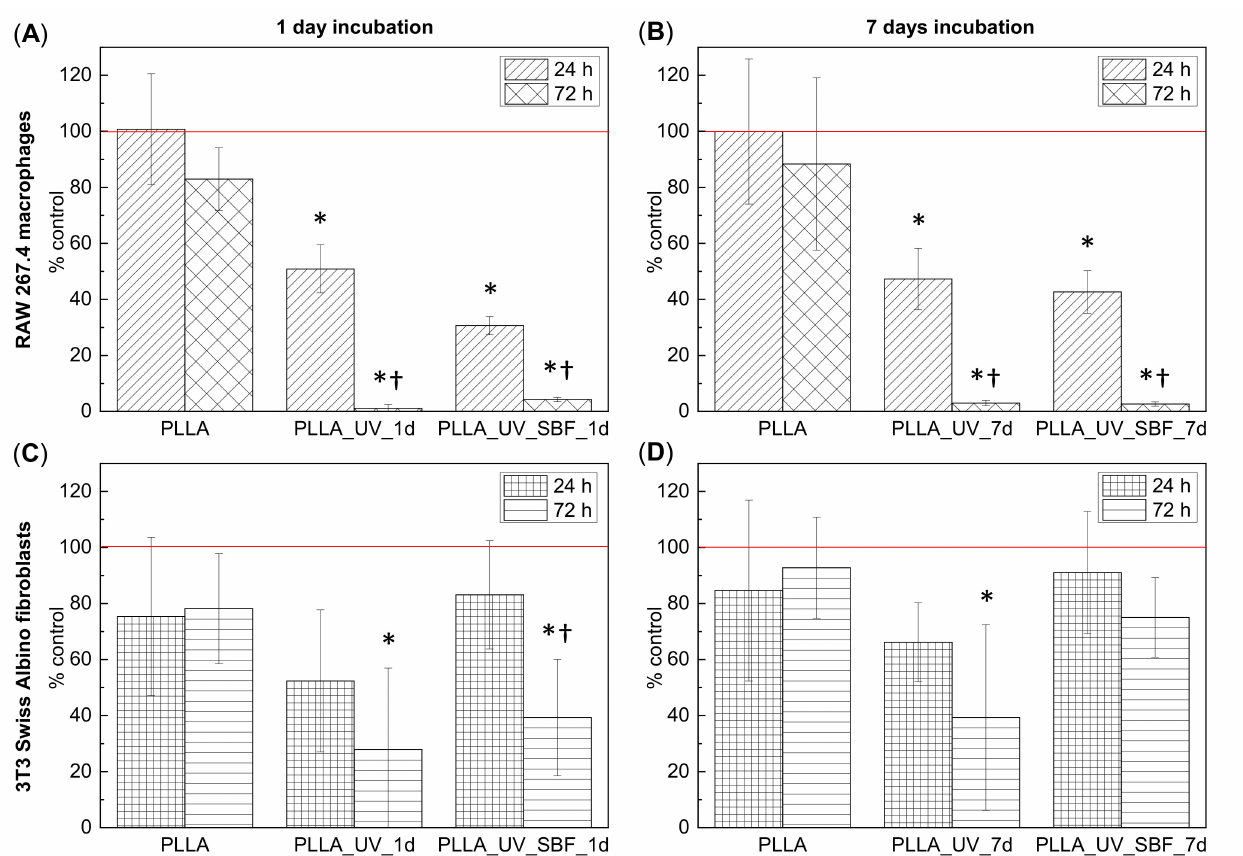
Figure 5. ( A , B ) Viability of the RAW 267.4 macrophages cultured for 24 h and 72 h on samples incubated for 1 day ( A ) and samples incubated for 7 days ( B ): unmodified polylactide (PLLA), laser-treated polylactide (PLLA_UV), and SBF- and laser-treated polylactide (PLA_UV_SBF) compared to the control (polystyrene). ( C , D ) Viability of the 3T3 Swiss Albino fibroblasts cultured for 24 h and 72 h on samples incubated for 1 day ( C ) and samples incubated for 7 days ( D ): unmodified polylactide (PLLA), laser-treated polylactide (PLA_UV), and SBF- and laser-treated polylactide (PLA_UV_SBF) compared to the control (polystyrene). The red line corresponds to 100% of cells cultured on the control polystyrene. * indicates a significant difference compared to PLLA for the same duration of exposure. † indicates a significant difference between different times of exposure (24 vs. 72 h). p < 0.05 was considered